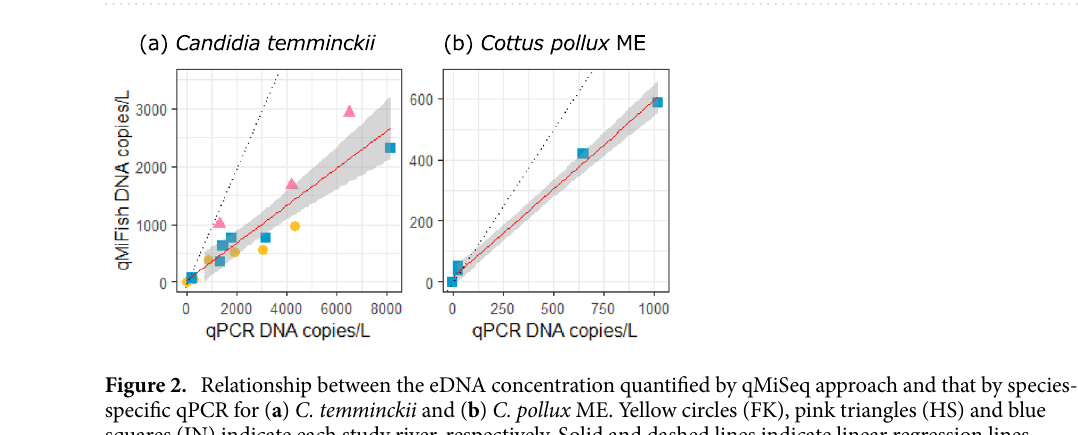
Figure 1. Overview of ( a ) the study sites and ( b ) survey design in this study. The bar and arrow in the bottom right-hand corner of the detailed maps in ( a ) indicate 2 km distance and water flow direction, respectively.